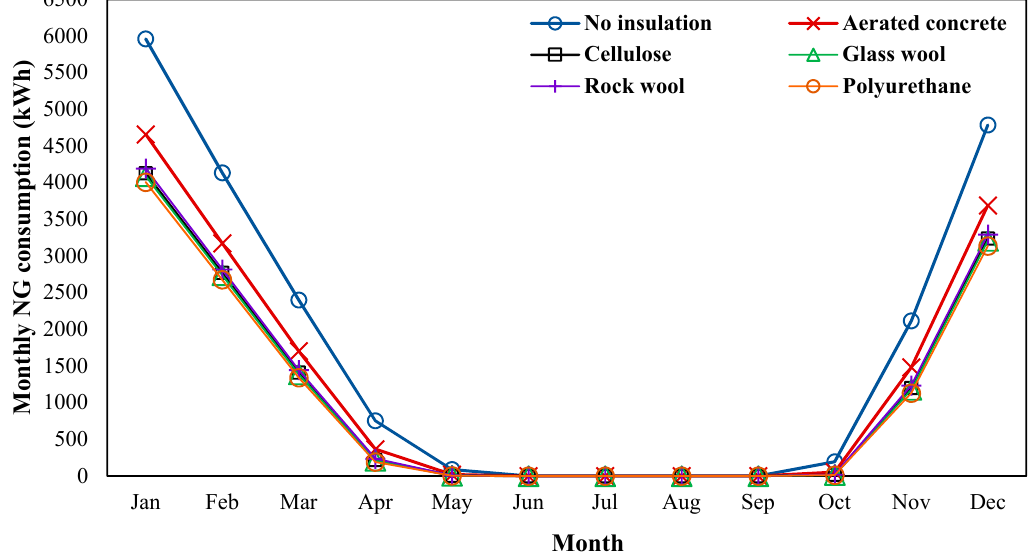
Figure 16. Monthly electricity consumption for different insulation materials.